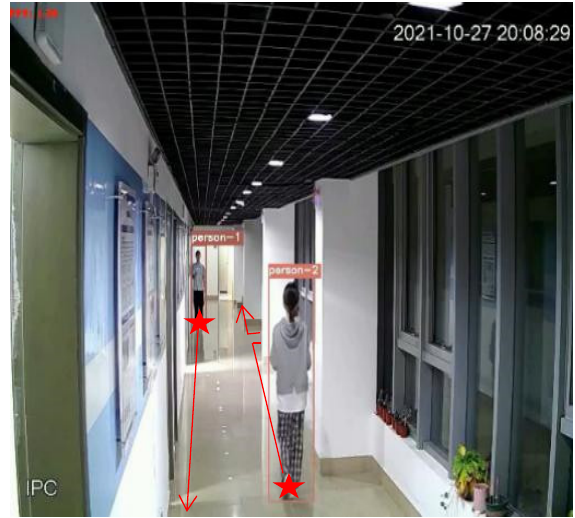
Figure 7. Experimental Scenario 1.